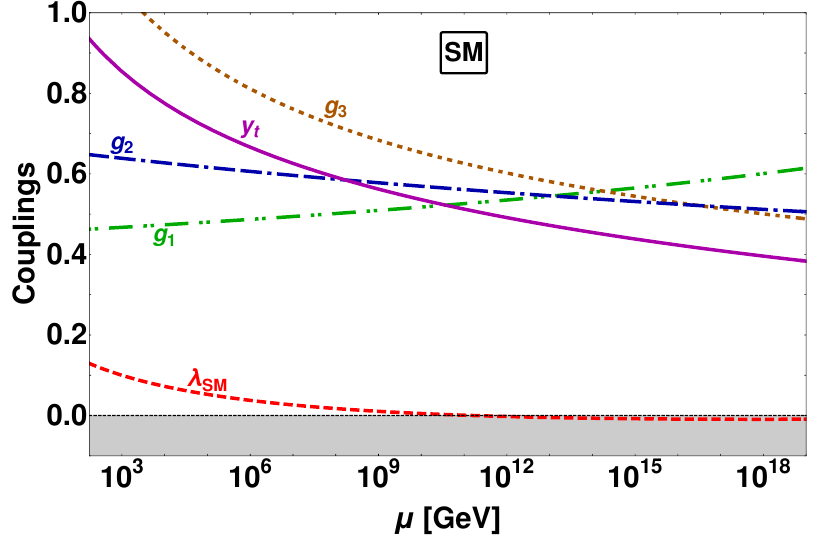
Figure 1 . The renormalization group evolution of the Standard Model gauge couplings g 1 , g 2 , g 3 , the top quark Yukawa coupling y t and the quartic Higgs boson self-coupling λ SM . Here we adopt the MS scheme, taking the parameter values at low scale as input, see [5] for